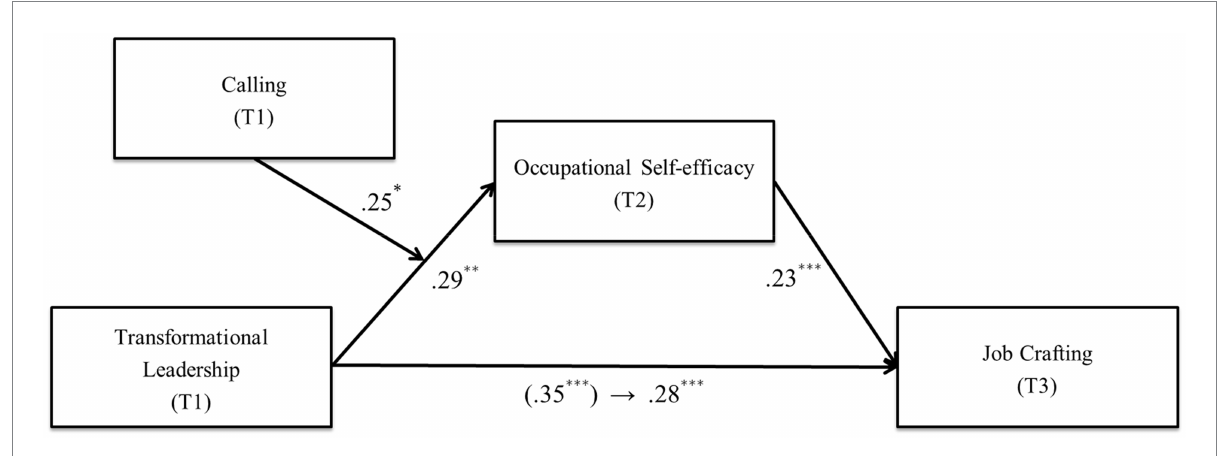
FIGURE 3 The moderated mediation model with the standardized coefficients. The number in parentheses is the direct path coefficient before the other variables are